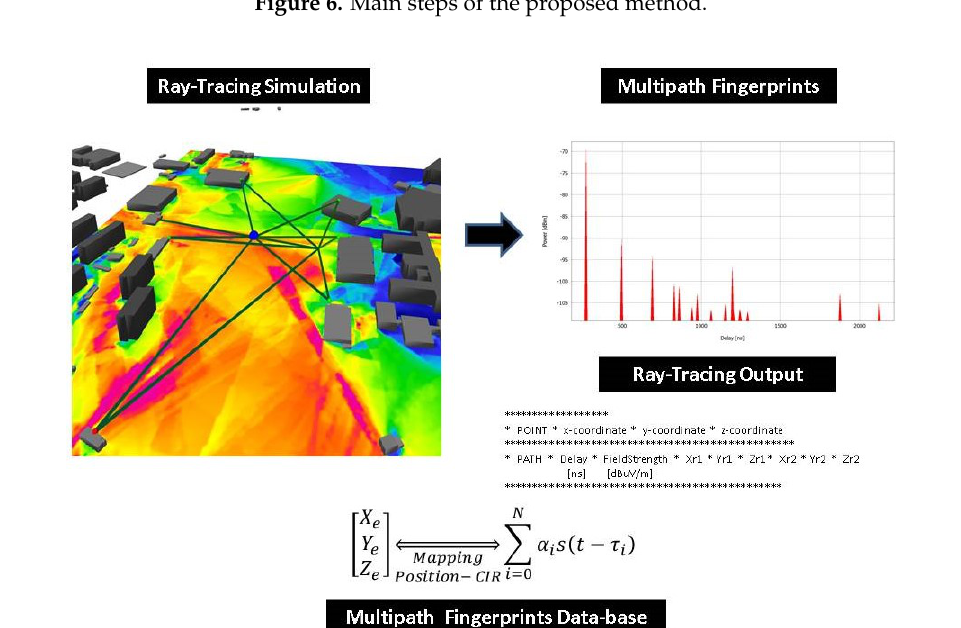
Figure 7. Multipath fingerprint database using ray-tracing